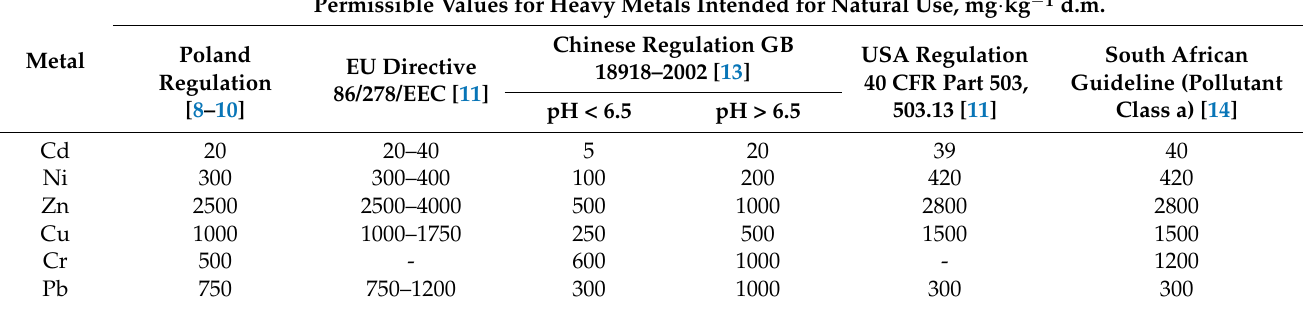
Table 1. Normative limit values for heavy metals in sewage sludge for natural use. Permissible Values for Heavy Metals Intended for Natural Use, mg · kg − 1 d.m. Metal